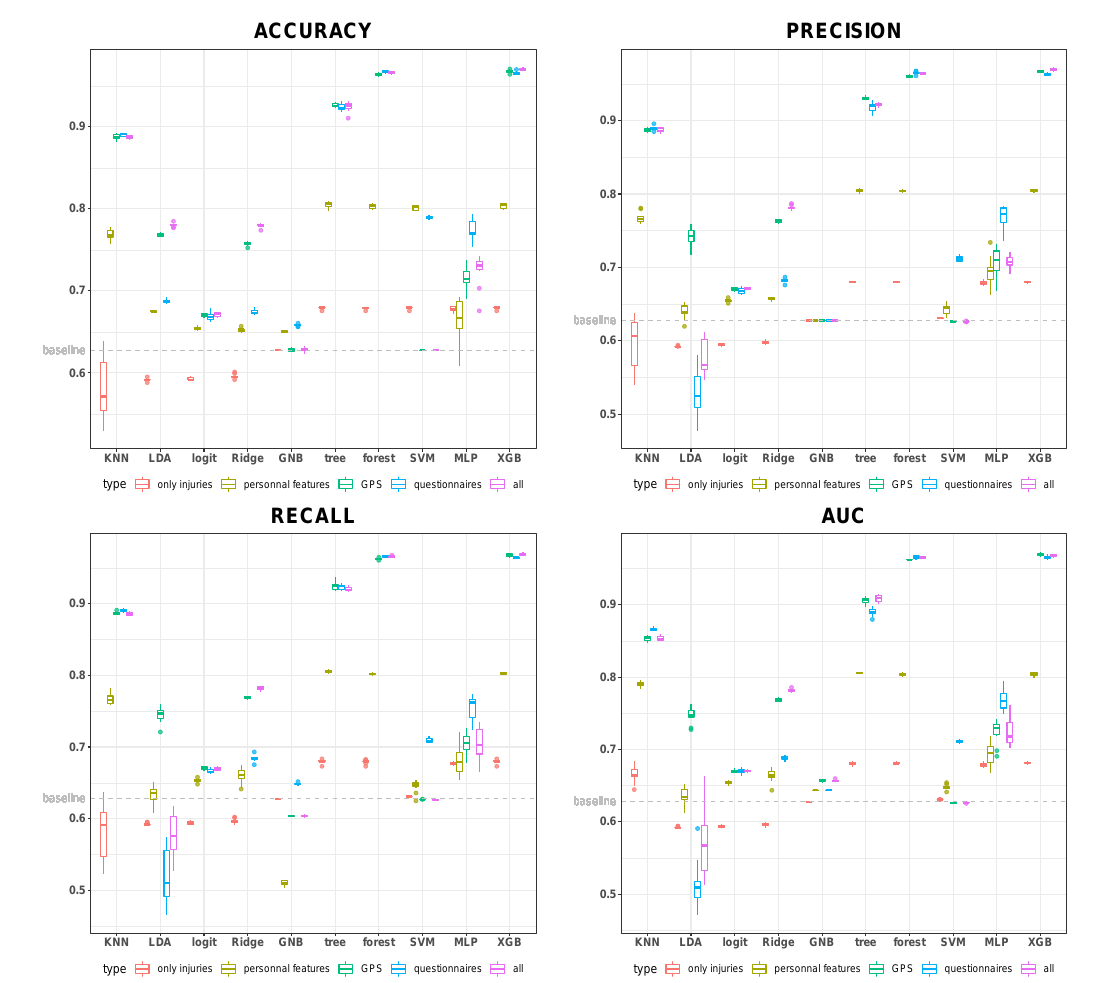
Figure 3. One-month predictive performance of ten machine learning methods according to five types (in color) of data sets. Predictive results are presented as box plots, in which the box indicates quartile values; the whiskers indicate the upper and lower values; circle indicates